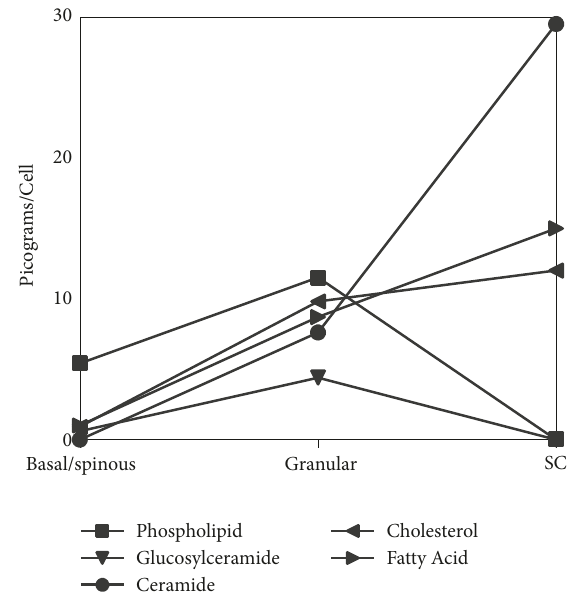
Figure 1: Alteration of epidermal lipid content and composition with differentiation based on data from Gray and Yardley